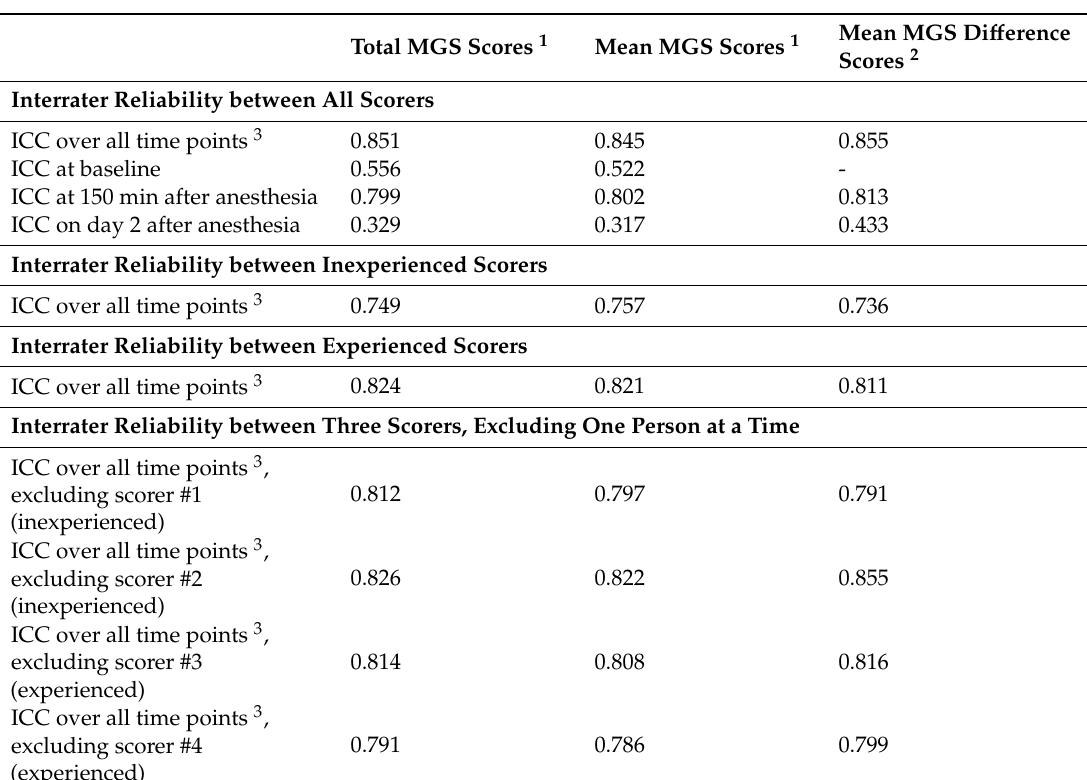
Table 1. Interrater reliability of overall MGS scores.